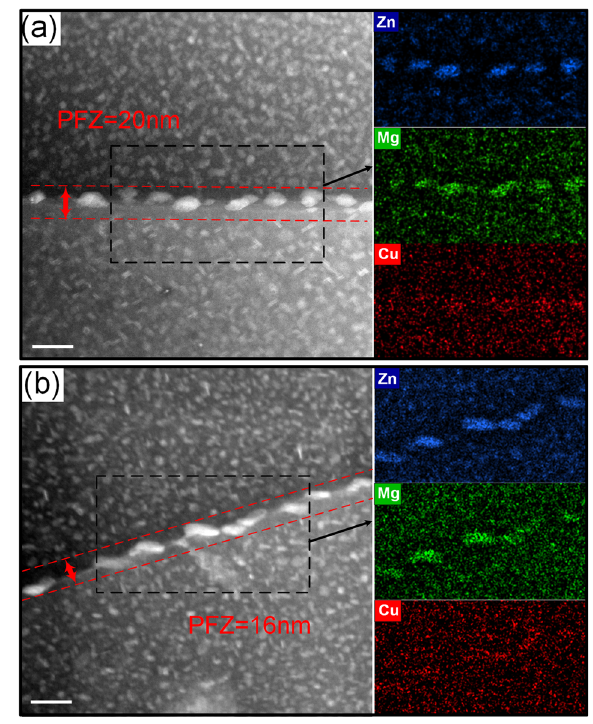
Fig. 5 Microstructure analysis at grain boundary. Morphology and element segregation at grain boundaries. a HT0-treated sample; b T66R-treated sample. Scale bars: 20 nm ( a , b ).